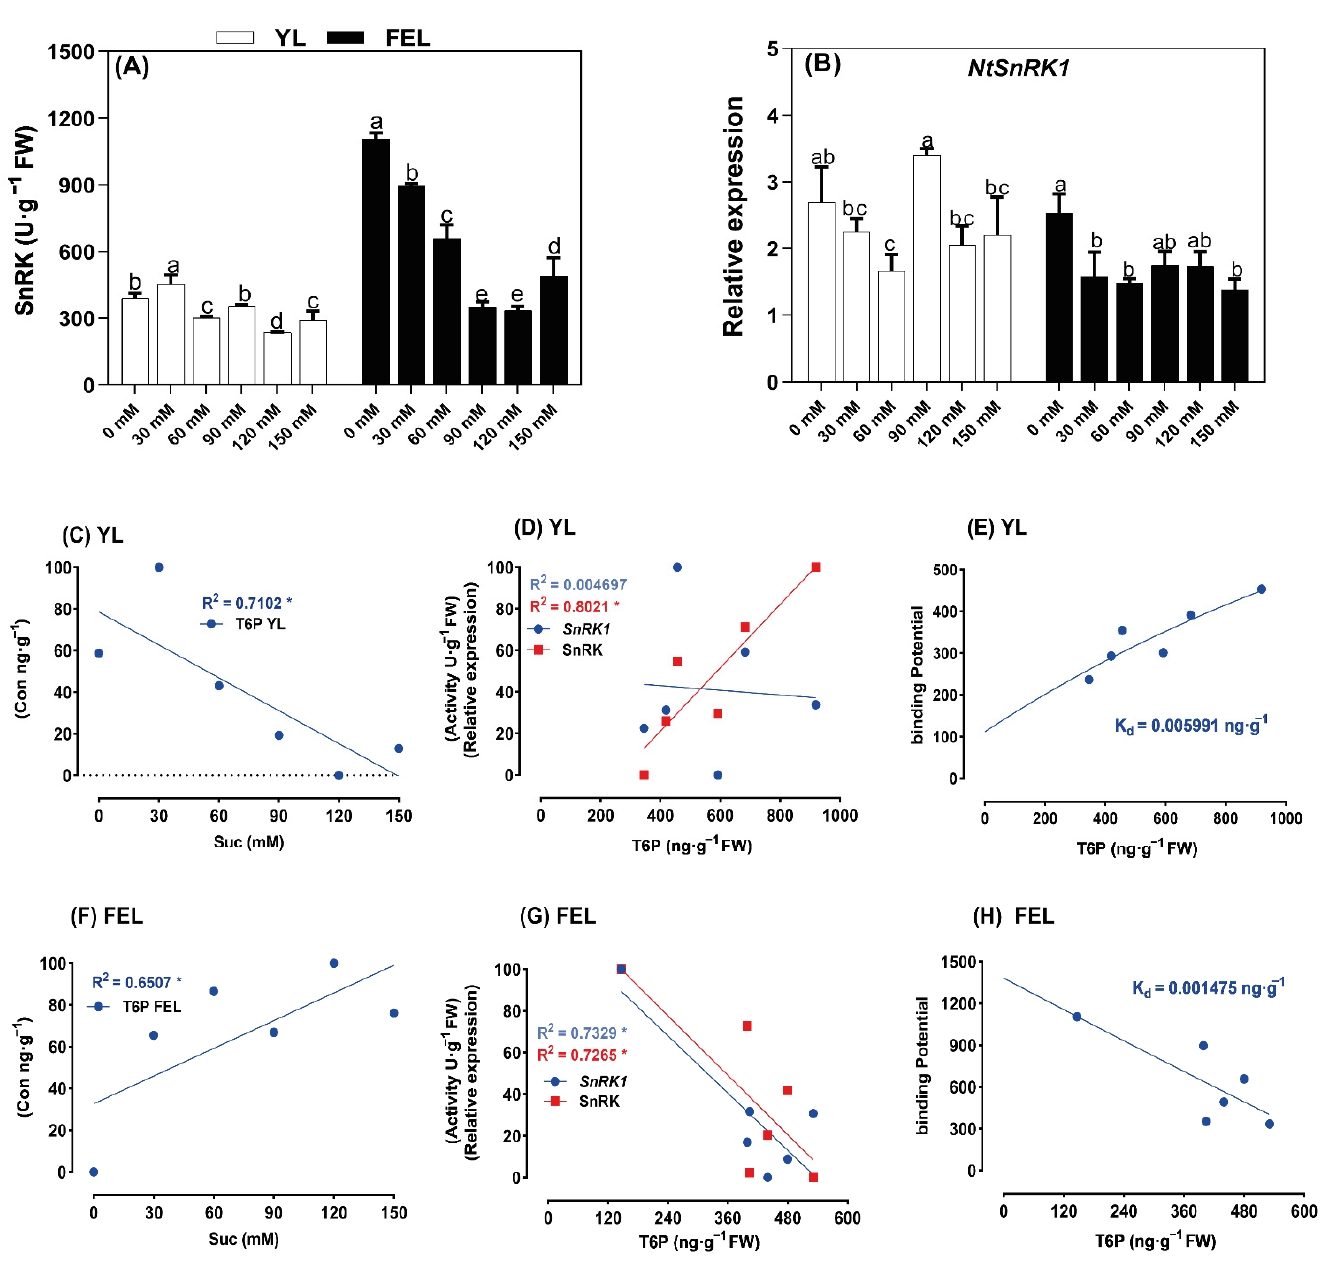
Figure 4. Exogenous sucrose (Suc)-dependent fluctuations in ( A ) SnRK enzyme activity and ( B ) NtSnRK1 expression in detached N. tabacum young leaf (YL) and fully emerged leaf (FEL) discs. Lowercase letters represent statistically significant differences at p ≤ 0.05. Error bars indicate standard deviation. ( C – H ) Linear regression analyses: Suc and T6P in YL ( C ) and FEL discs ( F ); T6P and